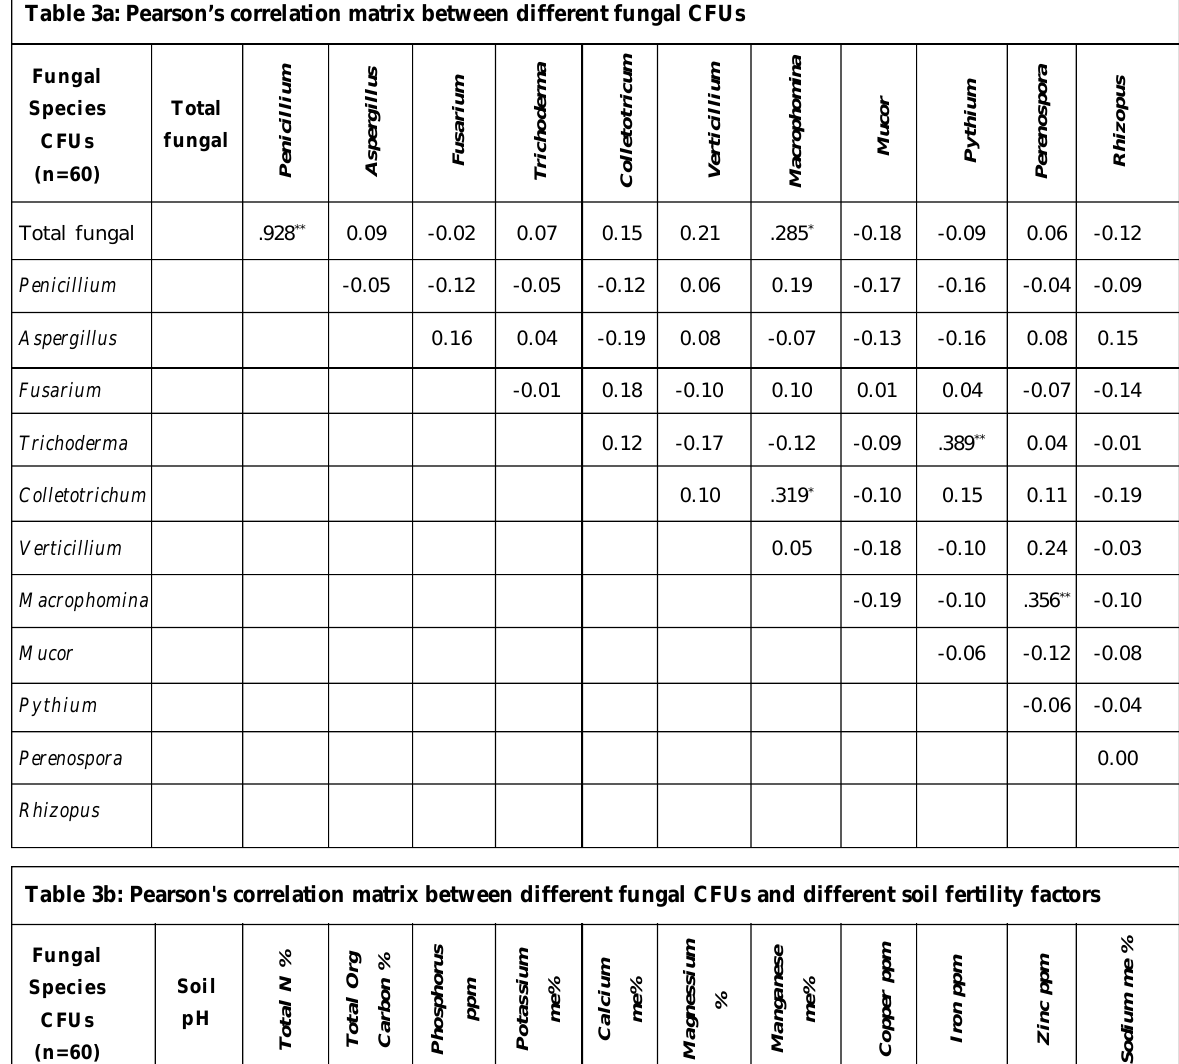
Table 3b: Pearson's correlation matrix between different fungal CFUs and different soil fertility factors Fungal Species